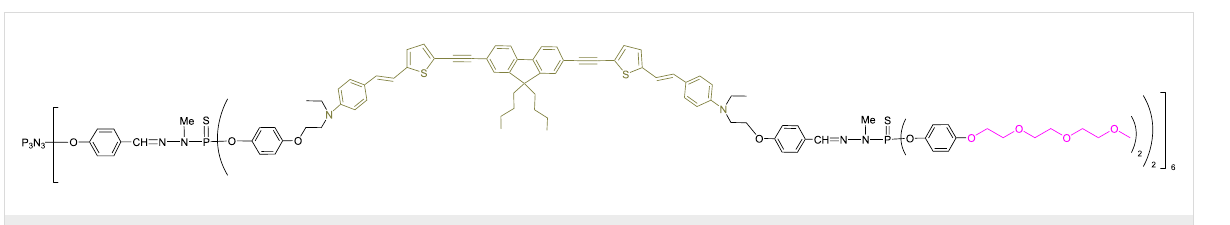
Figure 12: Schematization of the different types of TPA fluorescent phosphorus dendrimers and dendritic structures that have been already